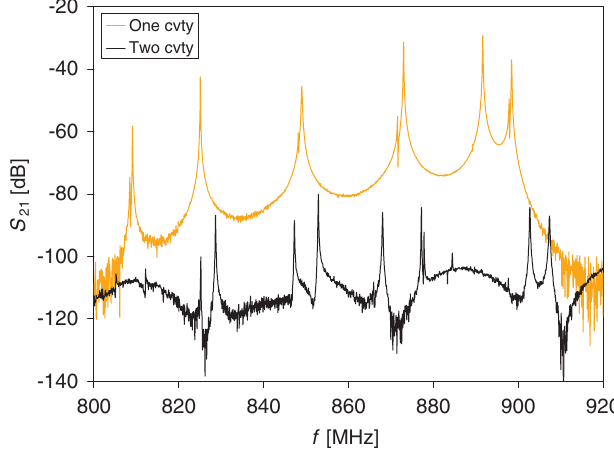
FIG. 18. Frequency splitting of HOMs in the combined ERL Cu